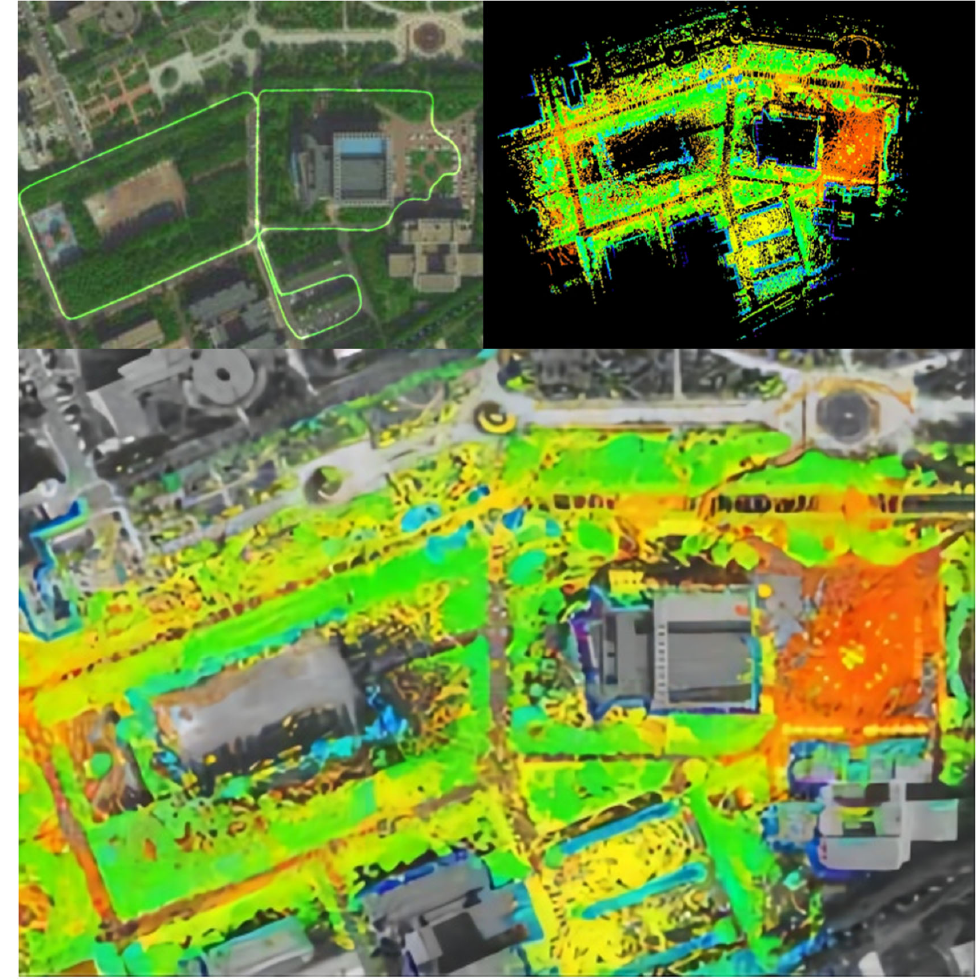
Figure 17. BEV image of the JLU_070102 sequence, LoNiC mapping results, and the superimposed renderings of the BEV image and the point cloud image (the colored trajectory in the BEV image refers to the actual trajectory of the Volkswagen Tiguan).